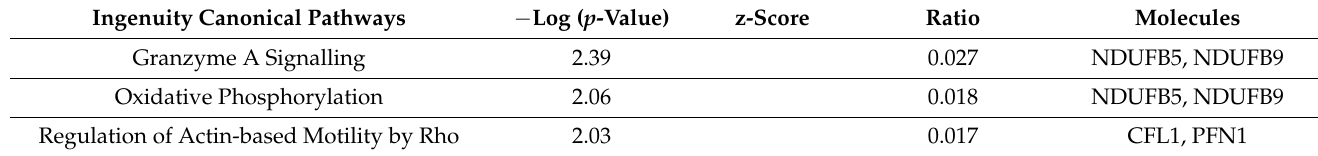
Table 5. Ingenuity pathway analysis of CA1 slices administered with OGD and MnTMPyP, com- pared to vehicle-treated OGD. Ingenuity-generated associated canonical pathways, ranked by − log ( p -value), reveal the top canonical pathways concern mitochondrial-mediated apoptosis (Granzyme A, p = 4.07 × 10 − 3 ), oxidative phosphorylation ( p = 8.7 × 10 − 3 ) and actin mobility ( p = 9.33 × 10 − 3